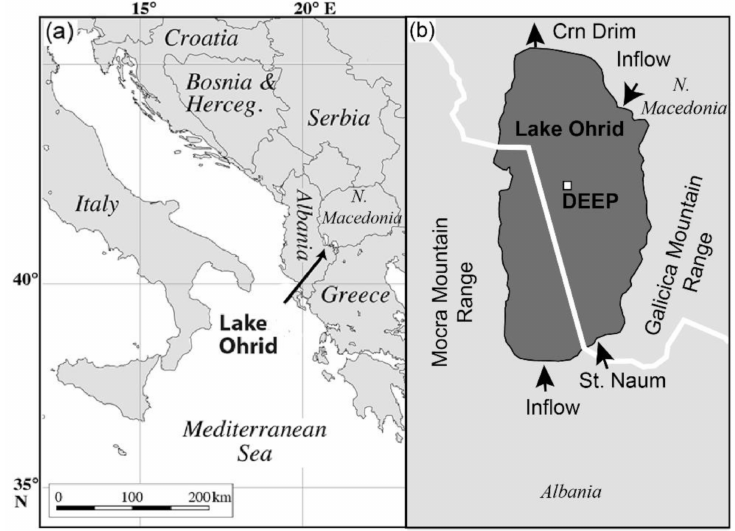
Figure 1. Map of the location of Lake Ohrid ( a ), and of the DEEP drilling site ( b ) at the border between N Macedonia and